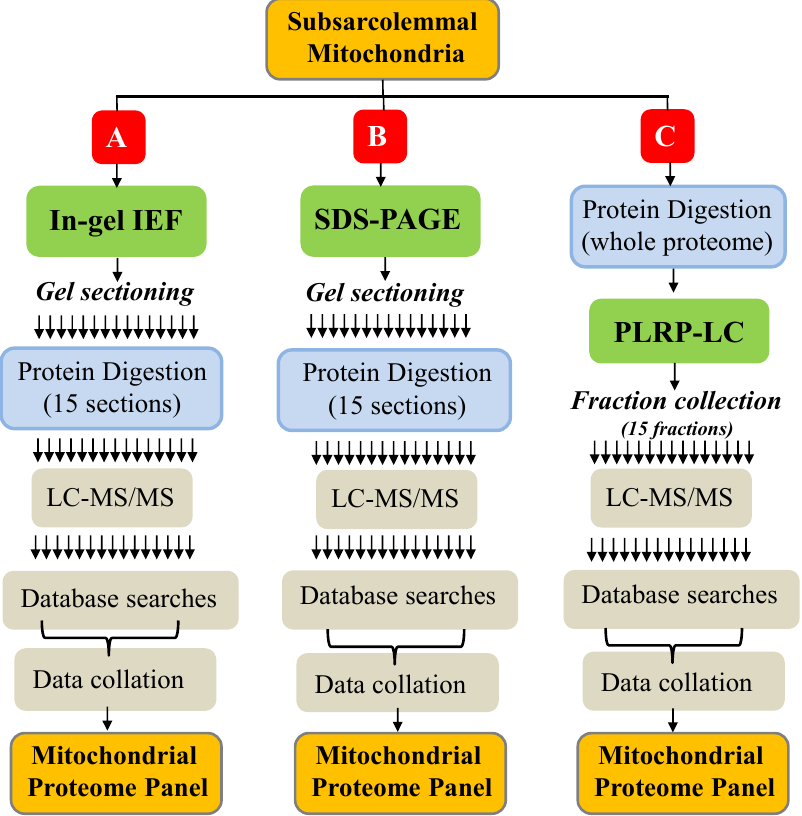
Figure 1. Experimental scheme for the comparative evaluation of three bioanalytical platforms for mitochondrial proteome profiling. Mitochondrial protein mixtures were separated at the protein level by in-gel isoelectric focusing (IEF) ( A ) or sodium dodecyl sulfate-polyacrylamide gel electrophoresis (SDS-PAGE) ( B ); or by PLRP (polymeric reversed-phase liquid chromatography at high pH) at the peptide level following proteolytic digestion ( C ). Fifteen gel sections ( A , B ) or 15 liquid fractions ( C ) were produced, and the peptide mixtures were analyzed by liquid chromatography-mass spectrometry/mass spectrometry (LC-MS/MS). The LC-MS/MS data were used to identify the proteins sampled with each platform. Three technical replicates were performed with each platform. Multiple arrows indicate multiple